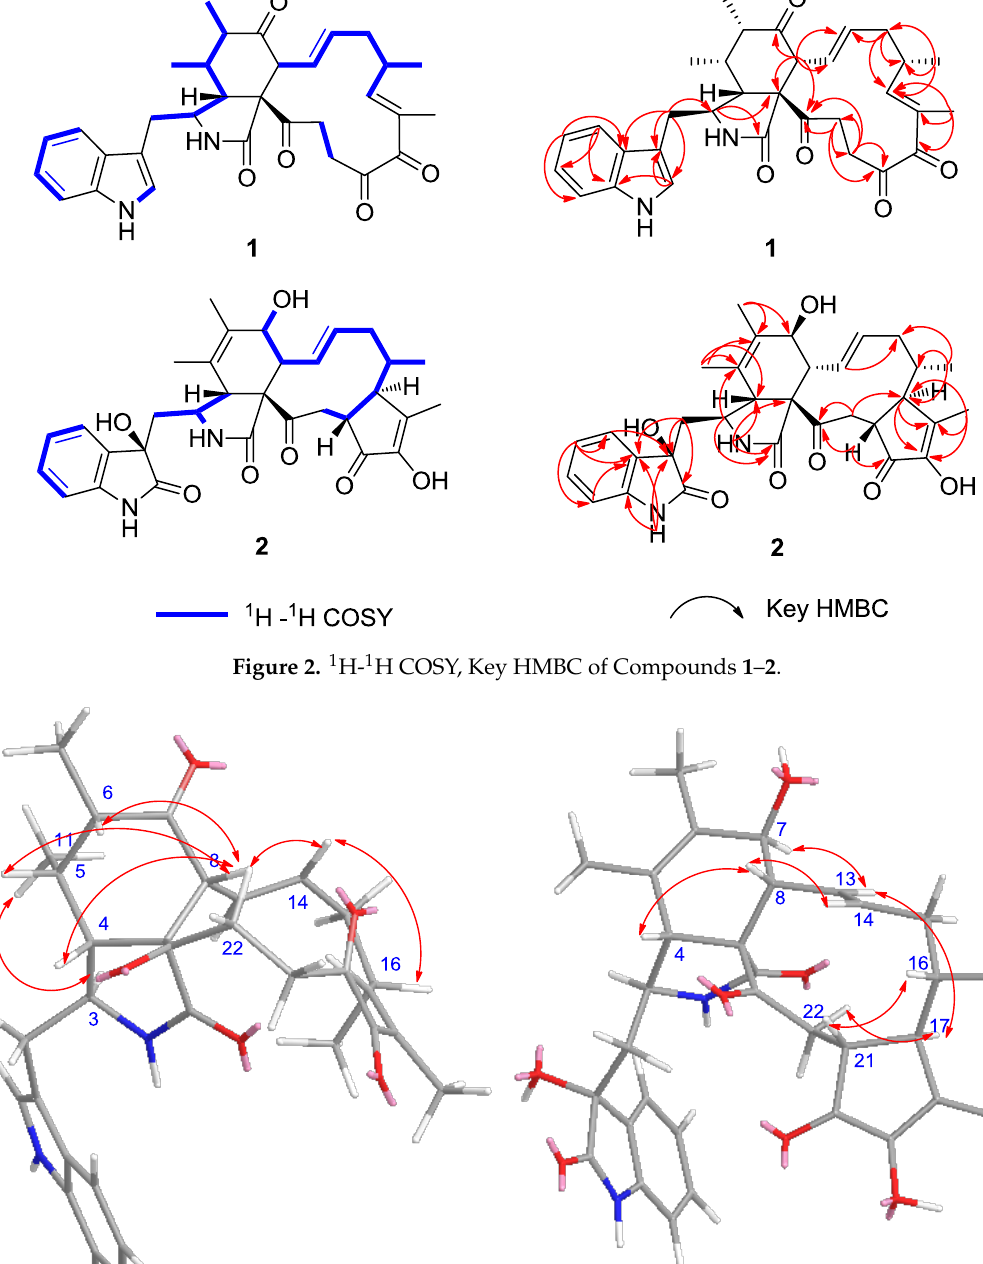
Figure 4. Experimental and calculated ECD spectra of Compounds 1 and 2 . Chaetomadrasin B ( 2 ) was also obtained as a white amorphous powder. The molecular formula of 2 was suggested to be C 32 H 36 N 2 O 7 on the basis of HR-ESI-MS ([M + H] + at m/z 561.2590). Detailed analysis of the 1 H and 13 C NMR spectra (Table 1) of 2 indicated that this compound was also a chaetoglobosin derivative. The unexpected hydroxy and carbonyl groups fused to the indole ring in 2 were evidenced by the chemical shifts of C-2′ ( δ C 178.8) and C-3′ ( δ C 74.6), as well as the HMBC correlations from H-10 to C-2′, C-3′, H-1′ to C-3′, H-3 to C-3′and H-4′ to C-3′ (Supplementary Figure S14). The complete structure of 2 was determined by correlative analysis of the 2D NMR spectra (Figure 3, Supplementary Figures S12–S14) and comparing the NMR data with chaetoglobosin V b ( 6 ) [22] and cytoglobosin A( 7 ) [23]. The observed ROESY correlations (Figure 3, Figure S15) of H-3/Me-11; H-7/H-13; H-4/H-10; H-8/H-14; H-16/H-21; H-13/H-17 closely resembled those of chaetoglobosin V b ( 6 ), indicating the same relative configuration. The identical biosynthetic pathways, relative configurations, and similar ECD spectra (Figure 2) between 2 and chaetoglobosin V b ( 6 ) suggests that both compounds share absolute configurations, except for their indole ring moieties. Subsequently, the ECD experiments and ECD calculations (Figure 2) of 2 were